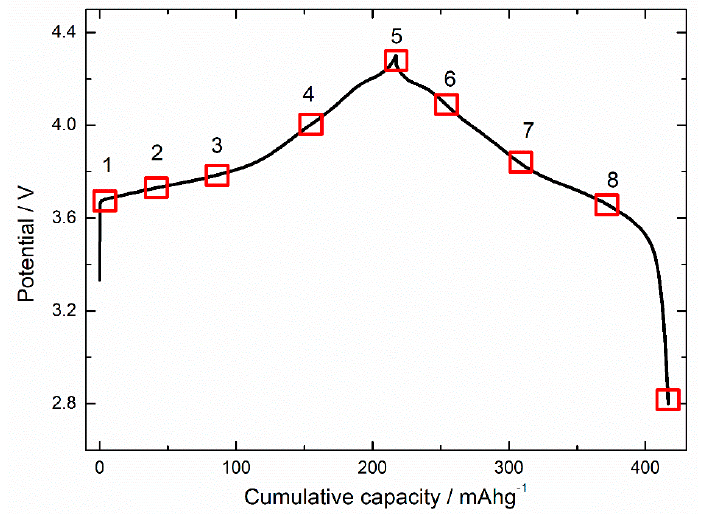
Figure 4. Various states of charging and discharging for NCM811 cathode materials.